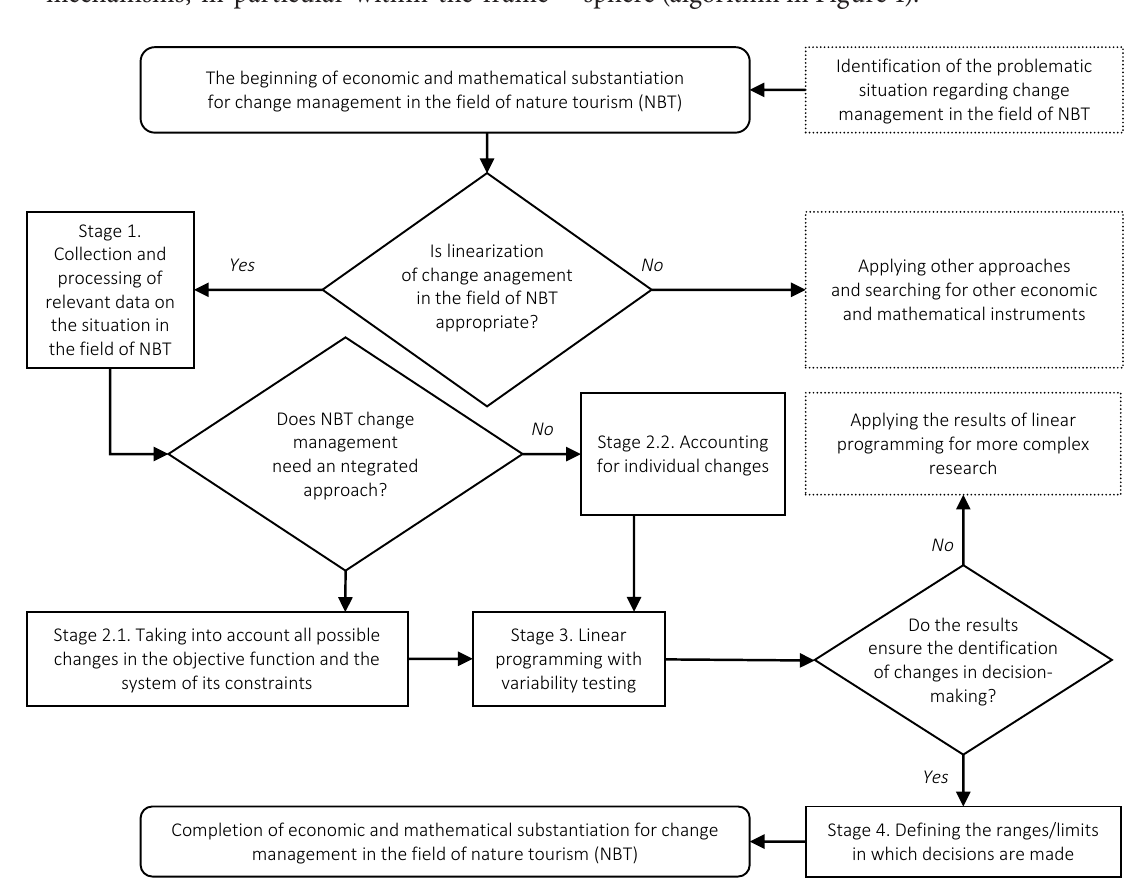
Figure 1. Algorithm for change management in the field of nature tourism based on linear programming